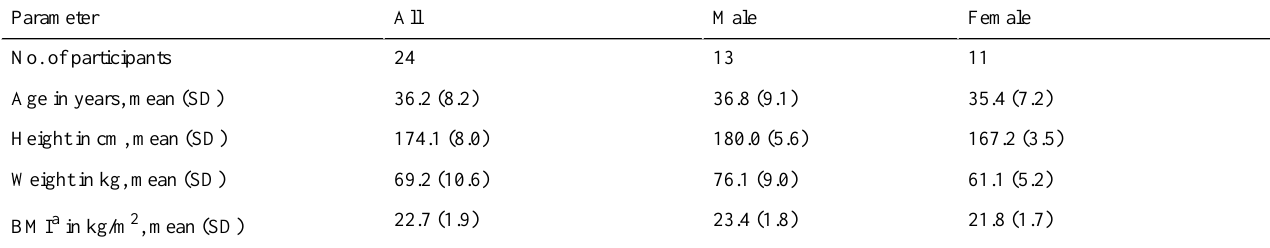
Table 1. Demographics of the participants. FemaleMaleAllParameter 111324No. of